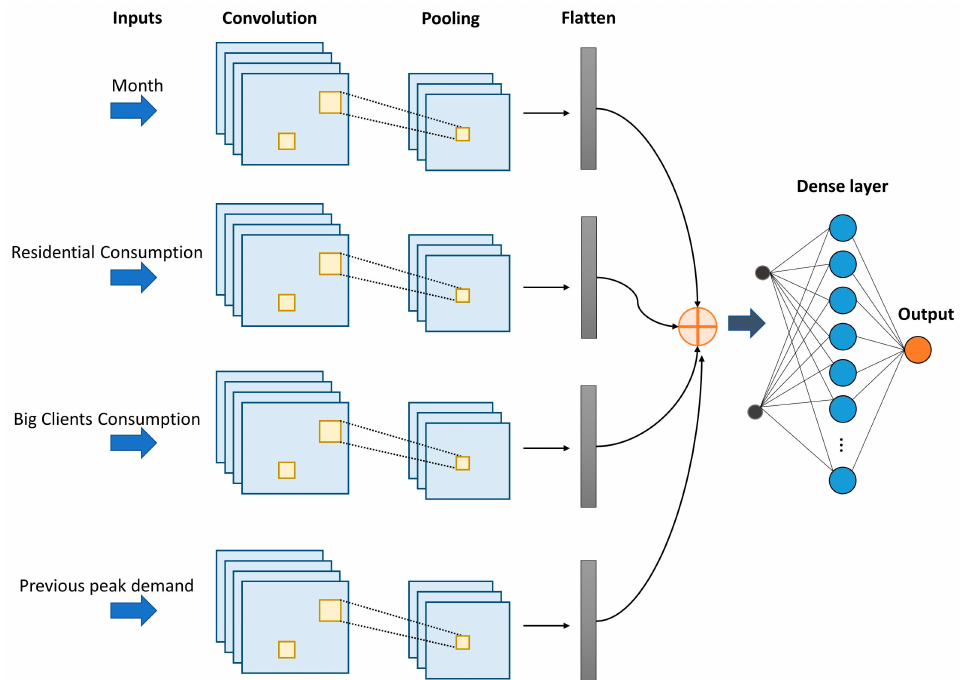
Figure 11. Multihead CNN